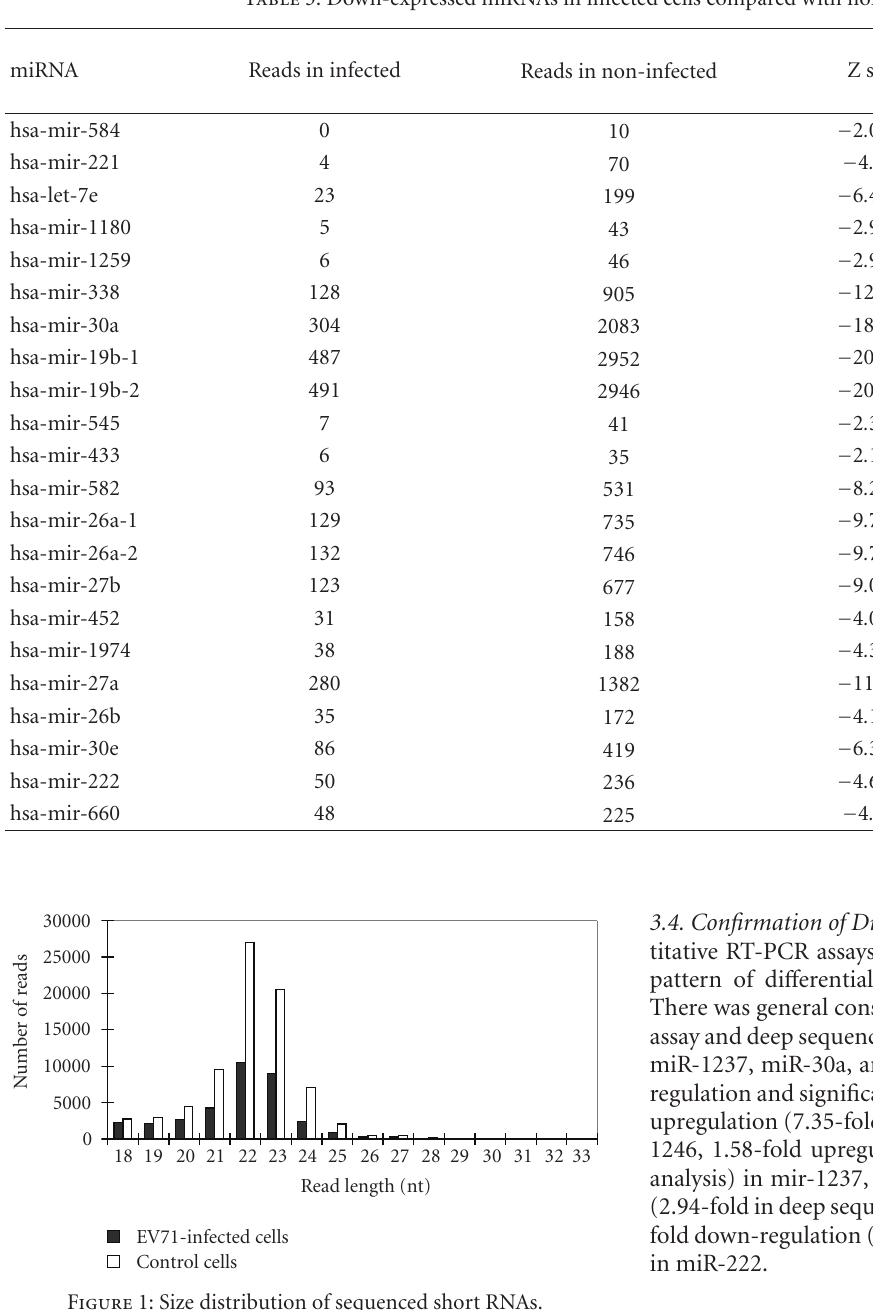
Table 3: Down-expressed miRNAs in infected cells compared with non-infected cells.